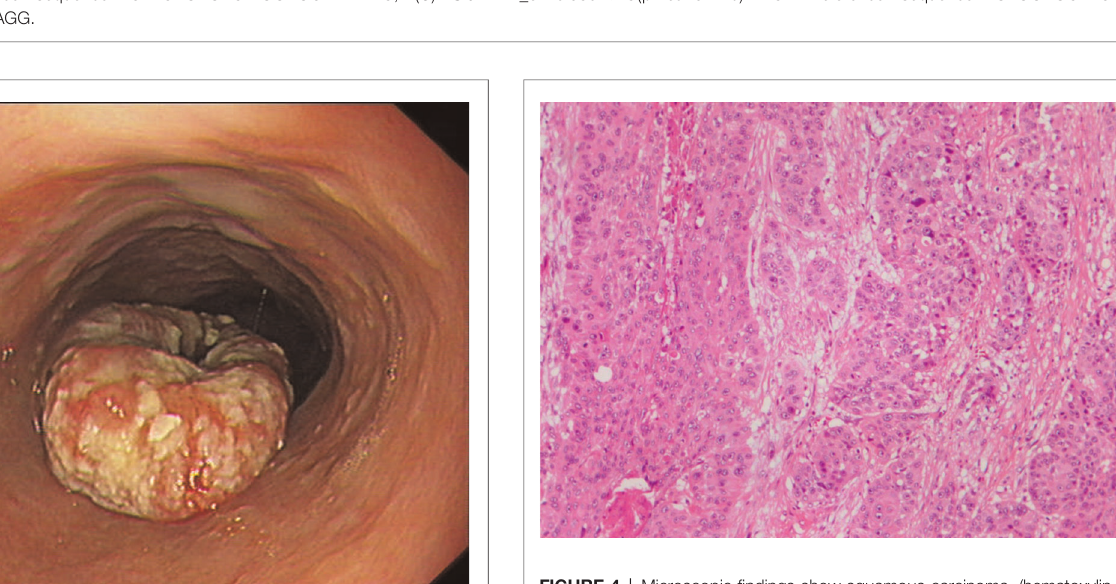
FIGURE 4 | Microscopic fi ndings show squamous carcinoma, (hematoxylin and eosin staining, magni fi